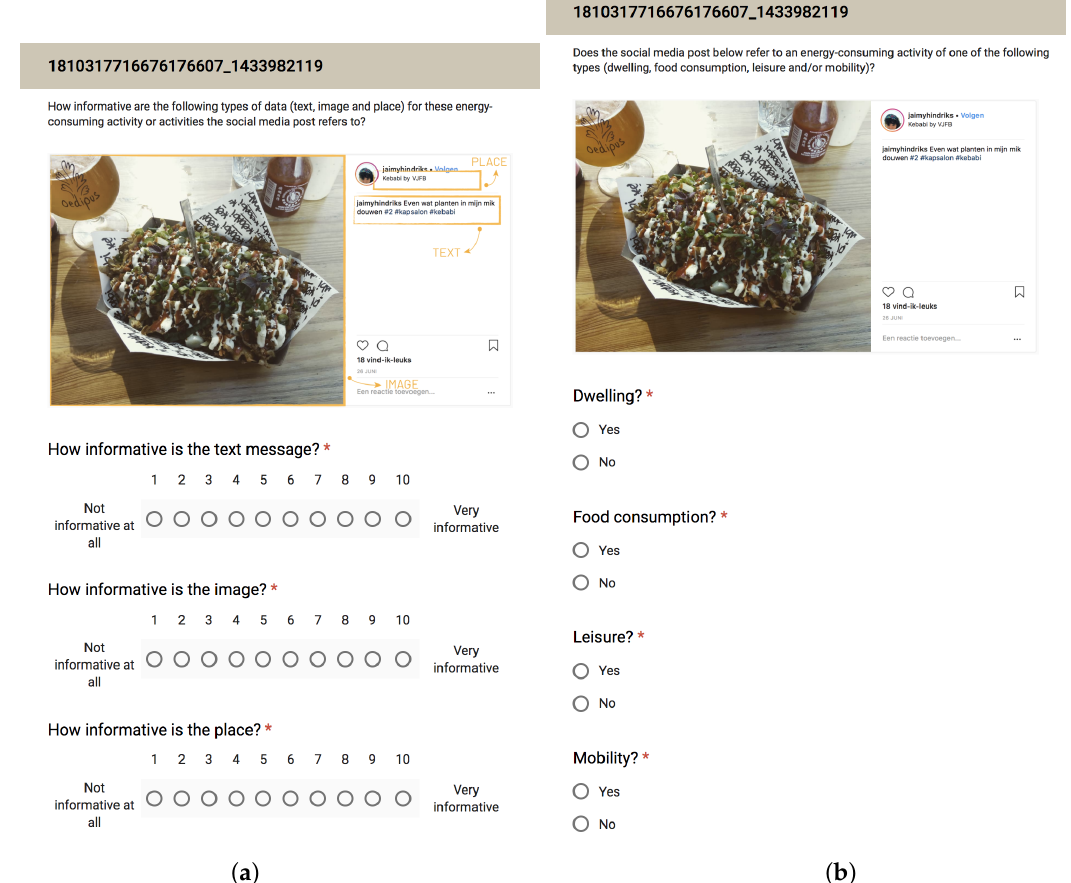
Figure A1. Example of question for tuning the weights ( a ) and creating the groundtruth ( b